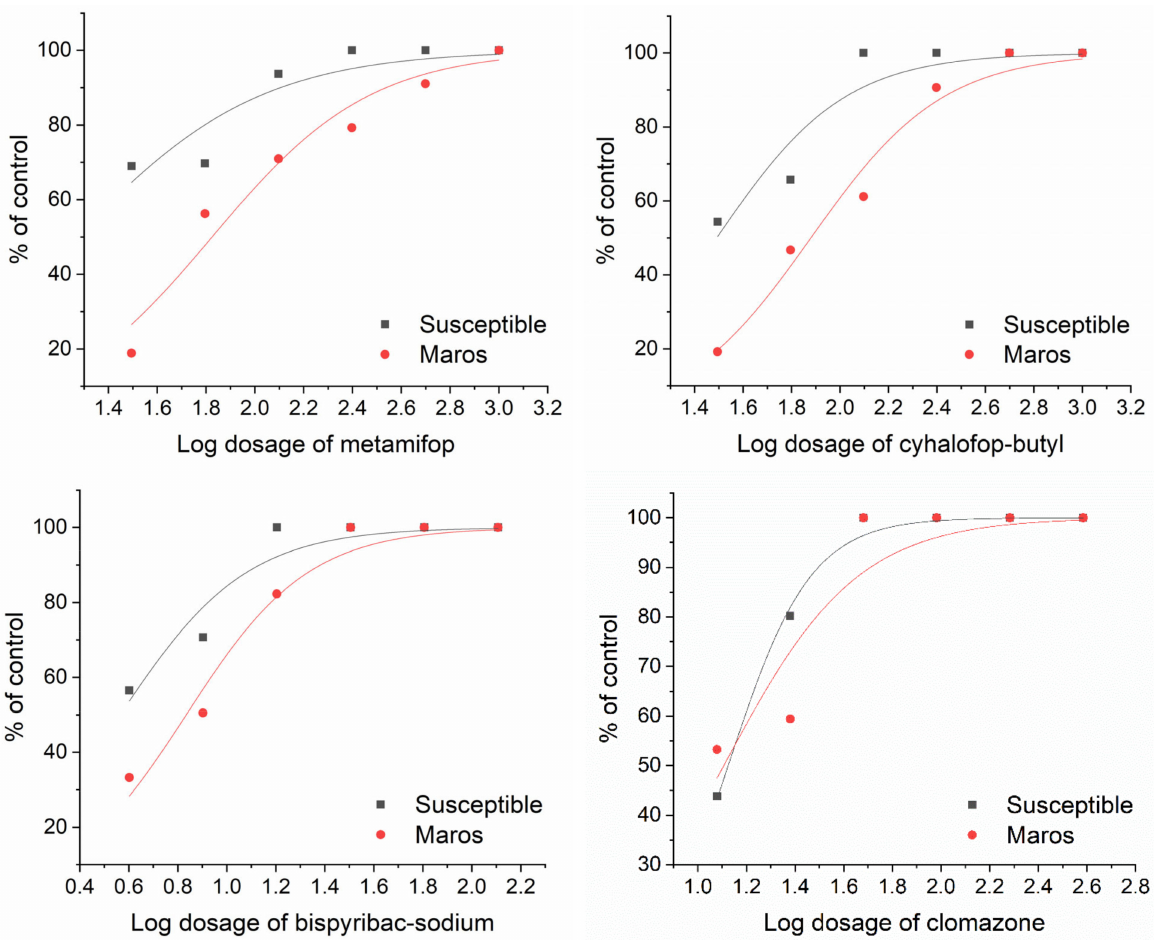
Figure 2. Growthreductioncurvesofsusceptibleandresistantbiotypesof L.chinensis byherbicideapplication. Table 2. Herbicide dose required for 50% reduction (GR 50 ) of dry biomass and resistance